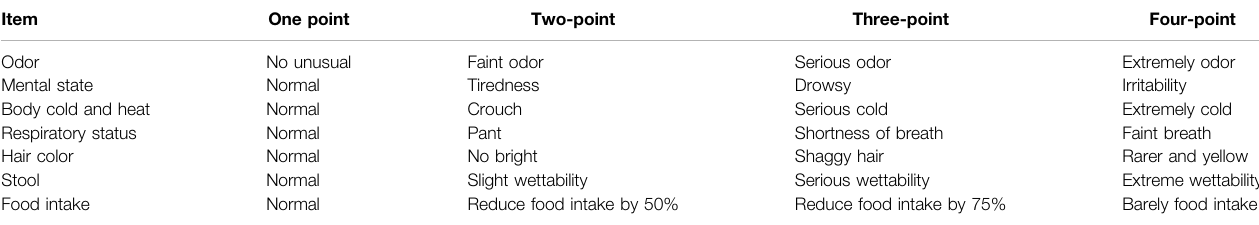
TABLE 1 | Spleen de fi ciency rating